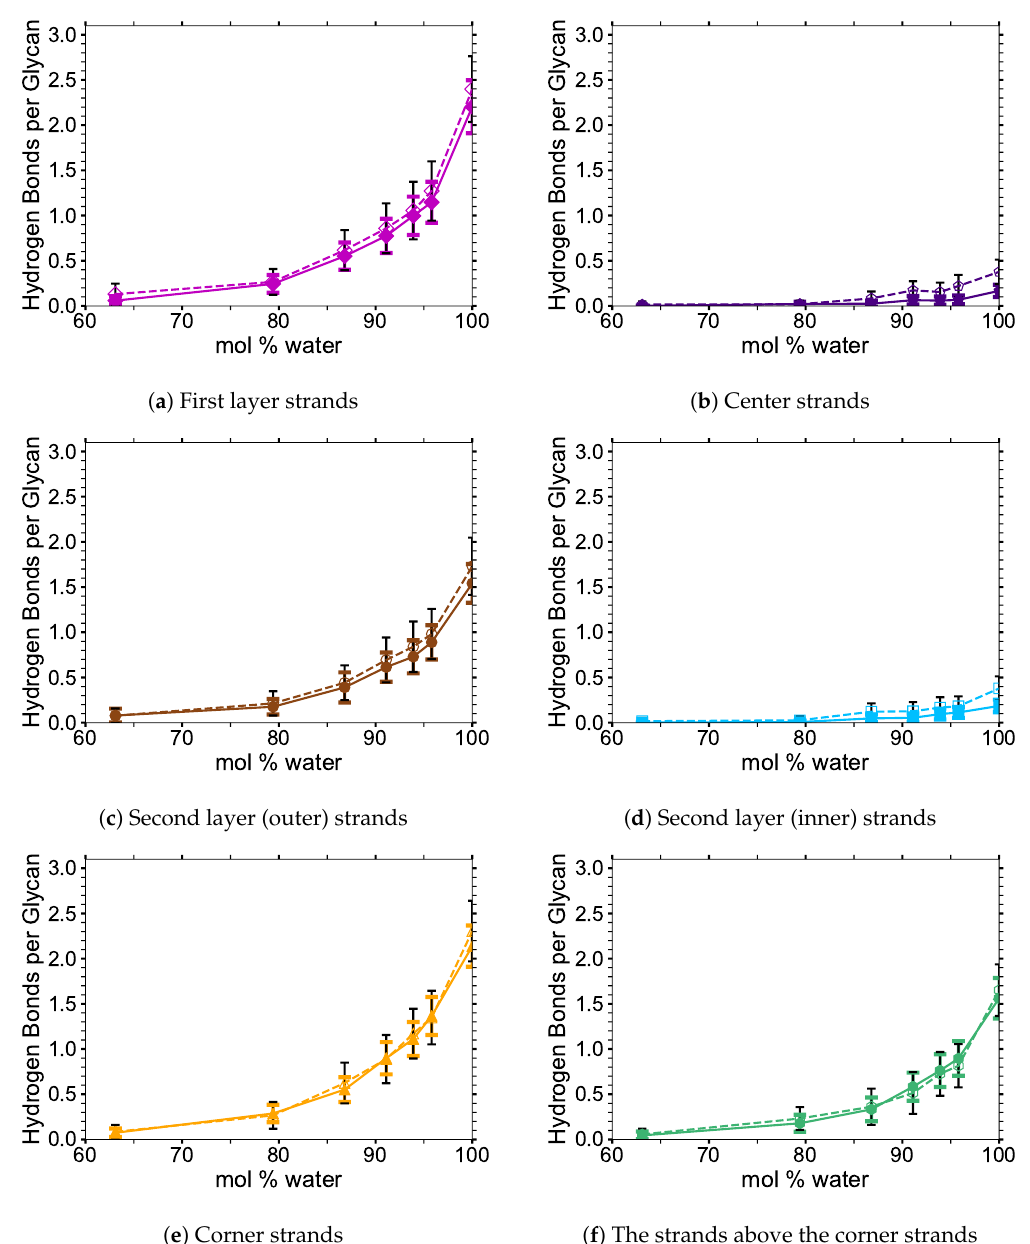
Figure A5. Average water-strand hydrogen bonding comparison with standard deviations between the small and large cellulose bundles at various water concentrations: ( a ) the first layer strands; ( b ) the center strands; ( c ) the second layer (outer) strands; ( d ) the second layer (inner) strands; ( e ) the corner strands; ( f ) the strands above the corner strands. All data points were averaged from 10 to 20ns. The solid lines, filled markers, and colored error bars represent the large cellulose bundle, and the dashed lines, unfilled marker, and black error bars show the small cellulose bundle. The colored strands are matched and compared between the plots for the small and large bundles and the images to identify similar hydrogen bonding behavior based on their locations (see Figure 6a,b for the color-coded images). The black cellulose strands are not